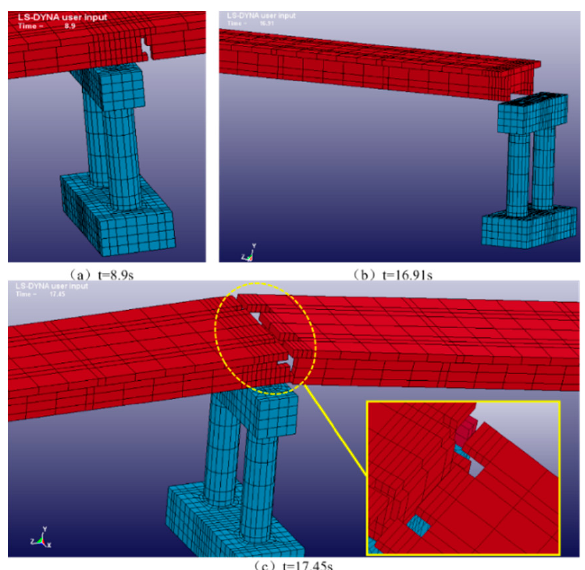
Figure 10. Longitudinal collapse mode of the bridge specimen under the Chi-chi wave.